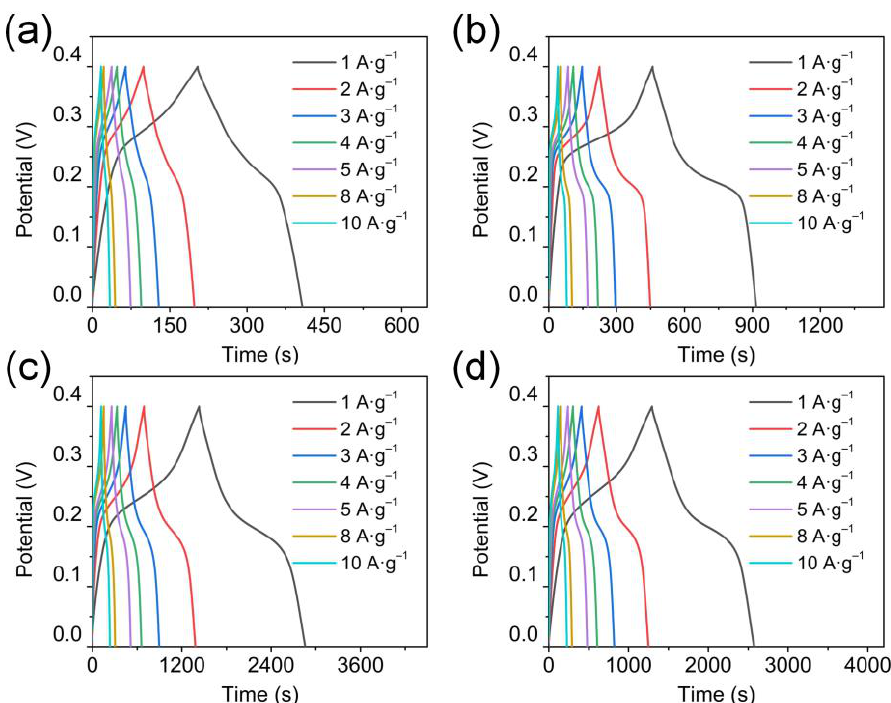
Figure 5. GCD curves of ( a ) CoO x -110, ( b ) CoO x -120, ( c ) CoO x -130, and ( d ) CoO x -140 at various current densities .